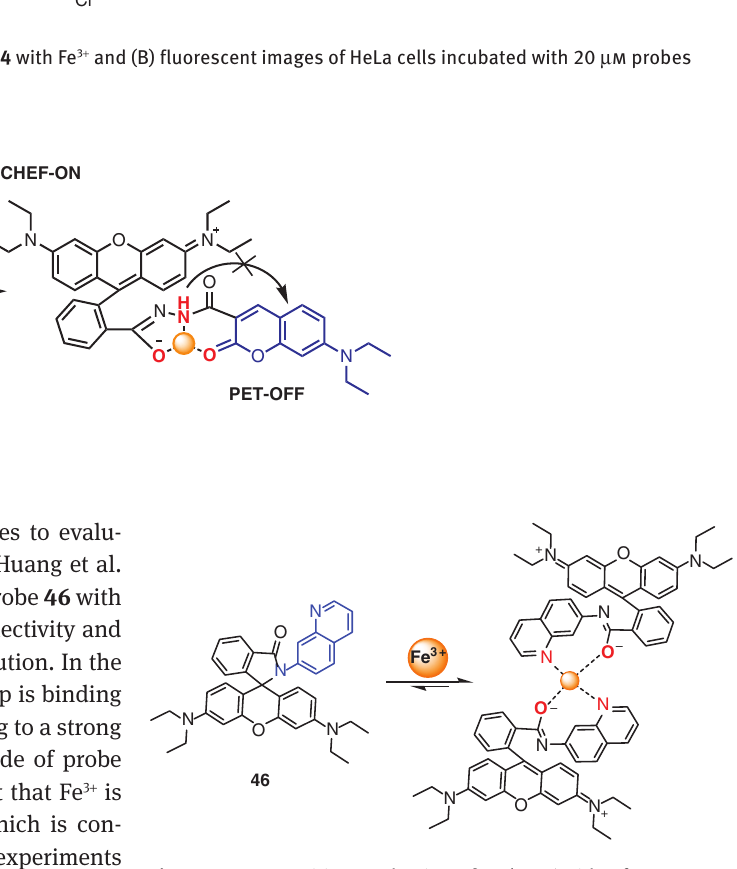
Figure 30: Recognition mechanism of probe 46 with Fe 3 +